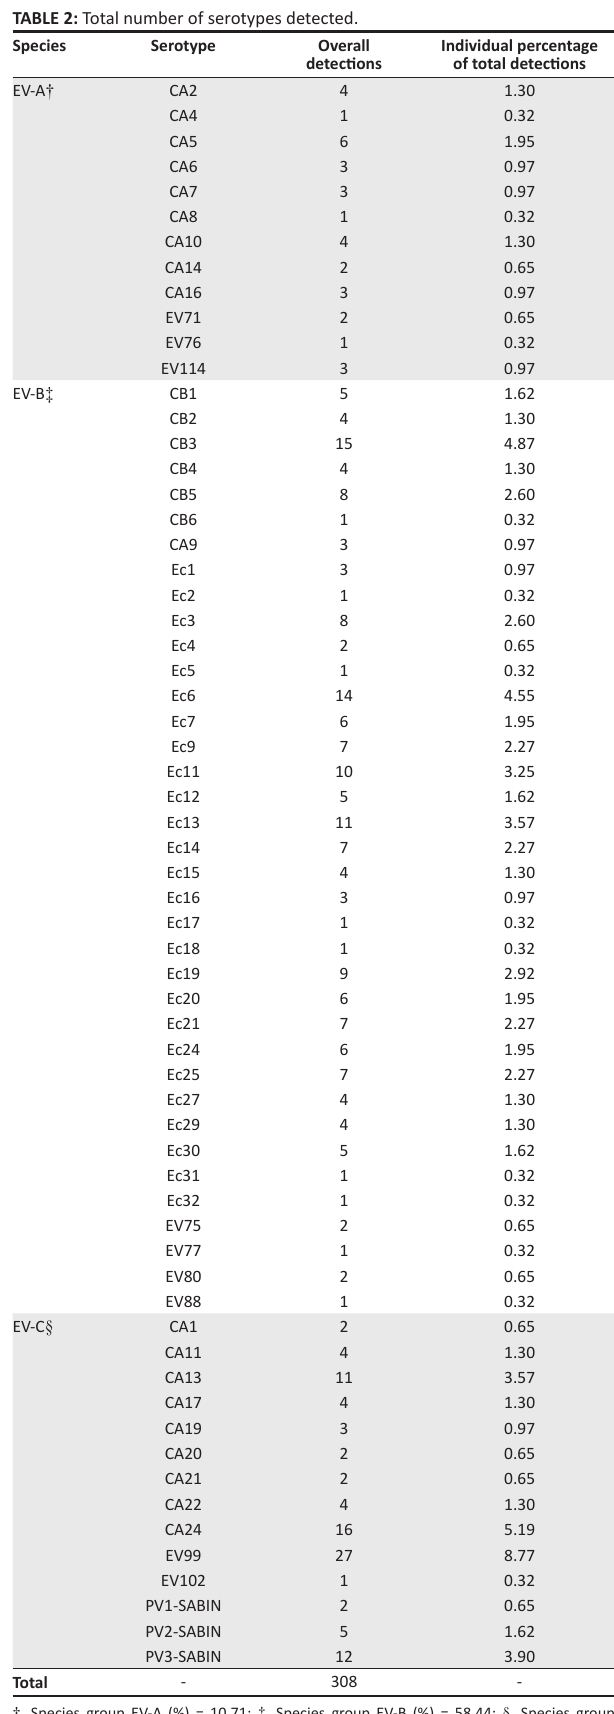
TABLE 2: Total number of serotypes detected. Species